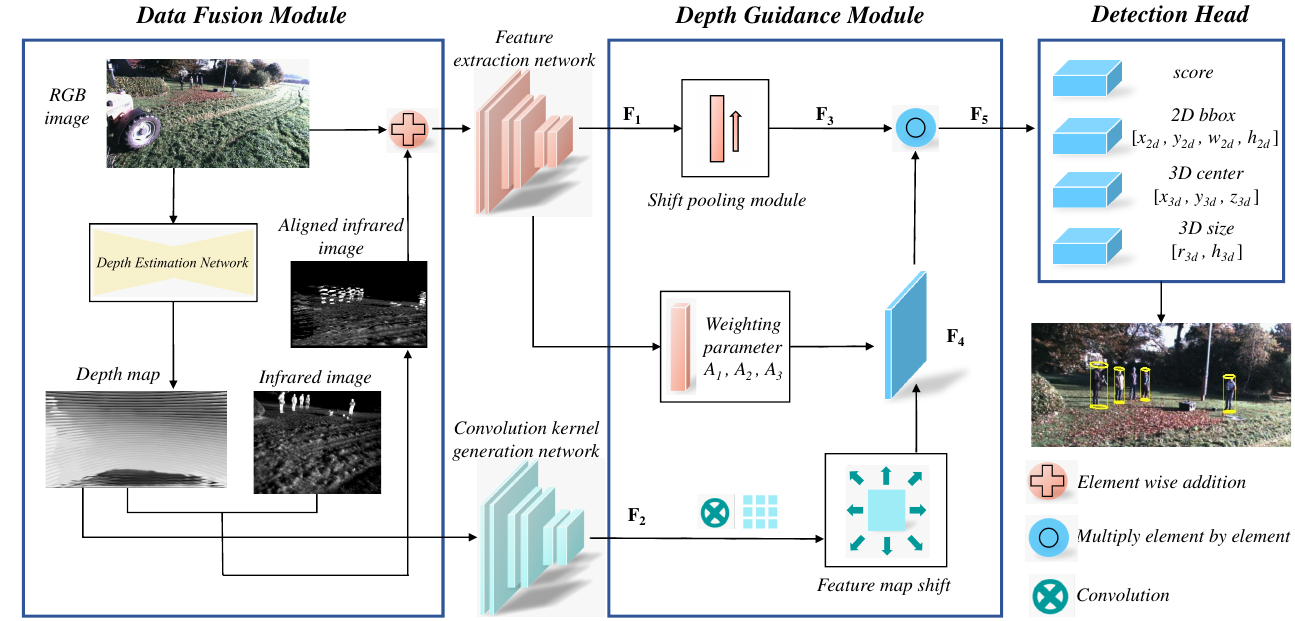
Figure 1. The framework of 3D pedestrian detection in farmland. Dataset generation and pedestrian detection are included in this work. The FIR image pixels are aligned with RGB image pixels by the estimated depth map. Concatenated image channels and estimated depth map are respectively imported to convolution networks to extract deep semantic features, which are further fused to predict the 3D cylinder label of each pedestrian in the agricultural